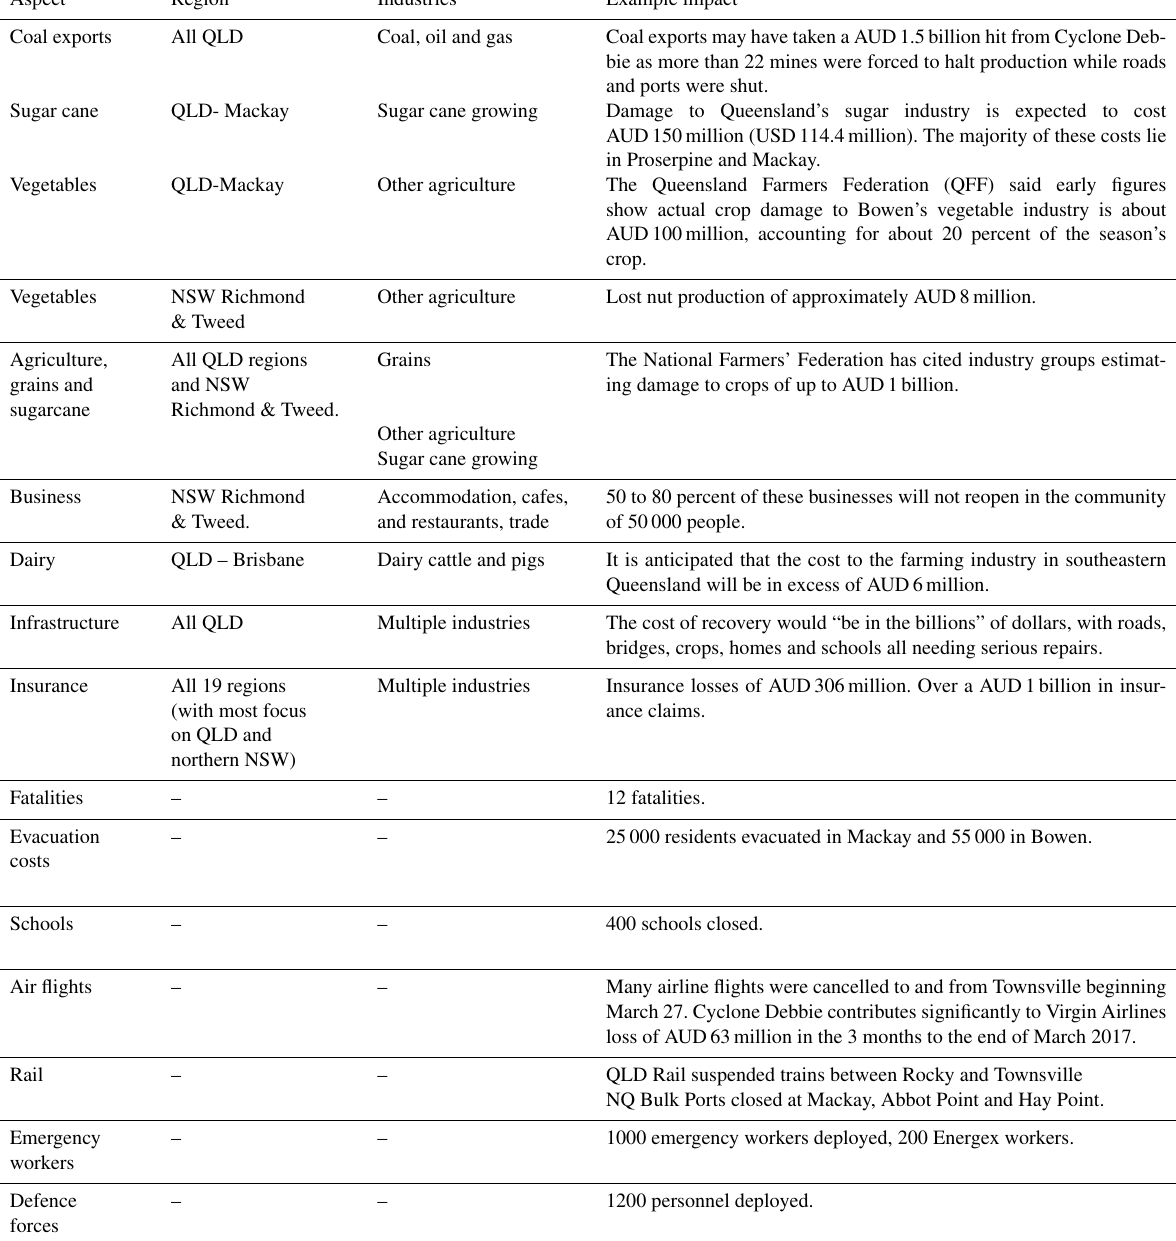
Table 1. Summary of major direct impacts (see Sect. S2 for details and sourcing).